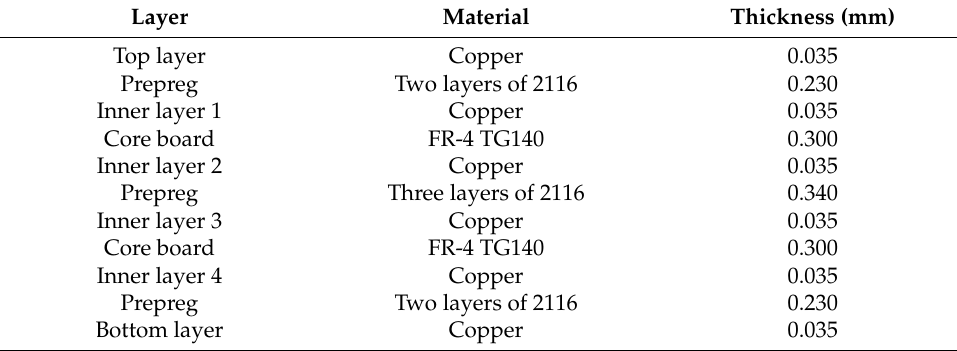
Table 1. PCB layers stack-up of the designed NFP.